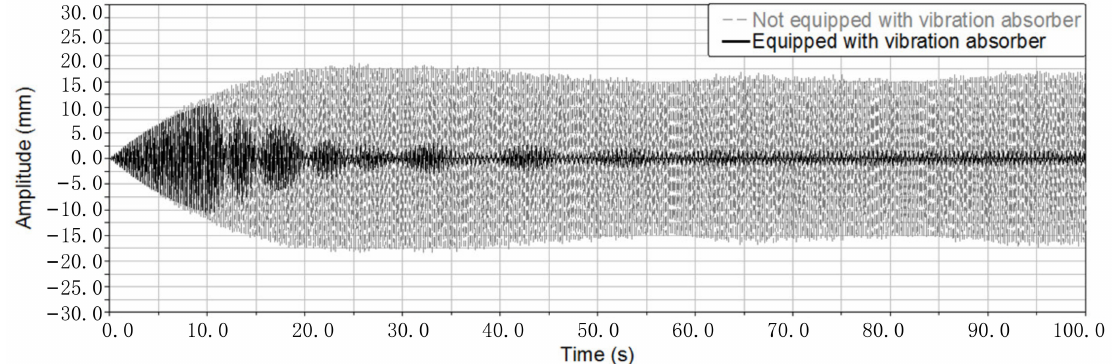
Figure 14. Comparison of primary resonance amplitude of the flexible manipulator with and without vibration